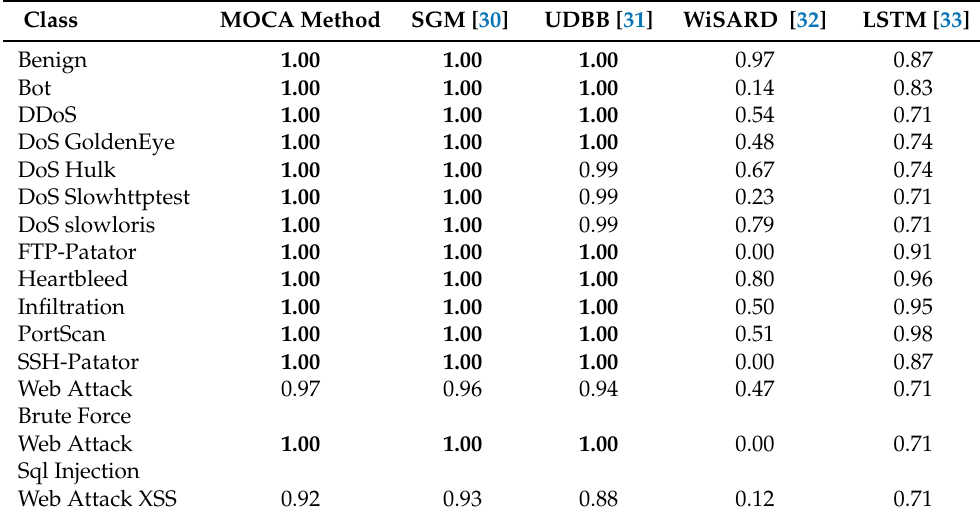
Table 5. Performance comparison of our method vs. previous works based on CICIDS2017 dataset.